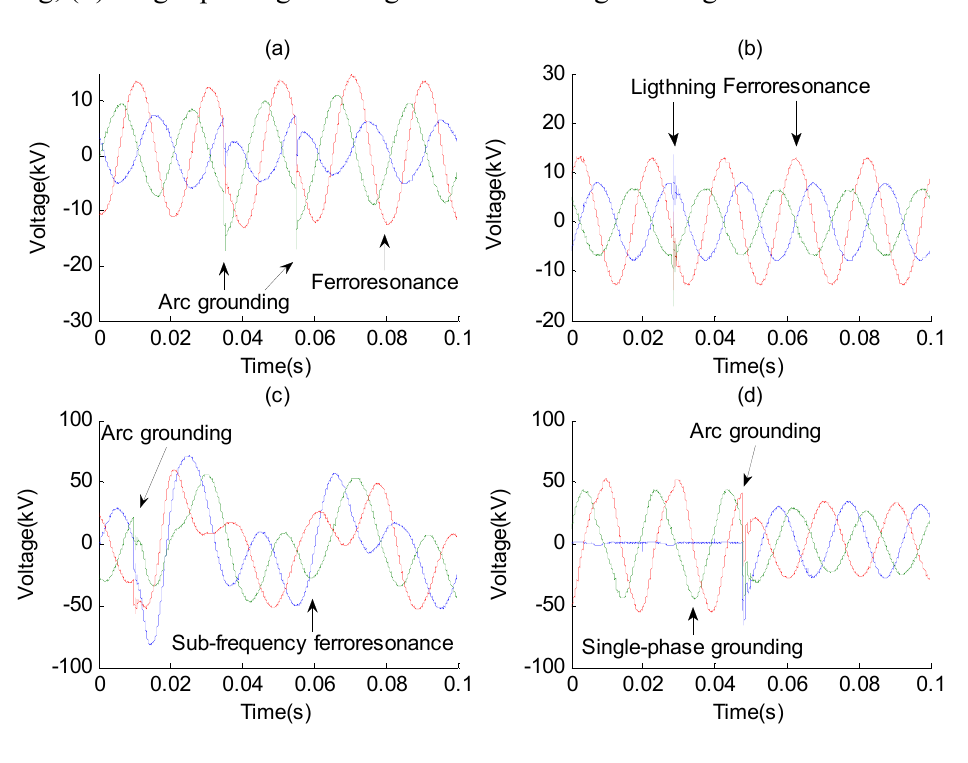
Figure 1. Four typical mixed over-voltages: ( a ) Ferroresonance mixed with arc grounding; ( b ) Ferroresonance mixed with lightning; ( c ) Sub-frequency ferroresonance mixed with arc grounding; ( d ) Single-phase grounding mixed with arc